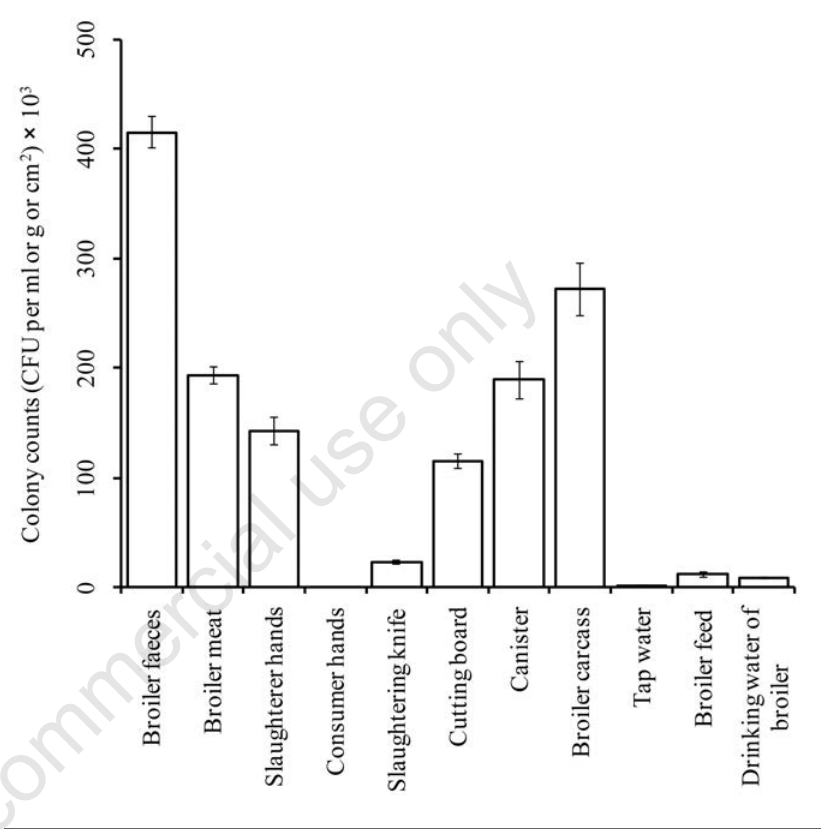
Figure 1. Colony count of Escherichia coli in broiler faeces (n=225), meat (n=225), slaughterer hands (n=50), consumer hands (n=50), slaughtering knife (n=50), cutting N board (n=50), carcass (n=50), tap water (n=50), canister (n=50), feed (n=50) and drinking water (n=50). Error bars are of standard deviation.